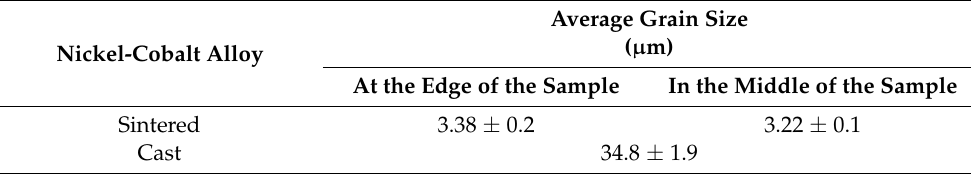
Figure 1. Microstructure of the workpiece material used in the current study before machining (sintered material) at magnification 1000 × ( a ) and 3000 × ( b ). Table 1. Average grain size of the materials calculated based on the secant